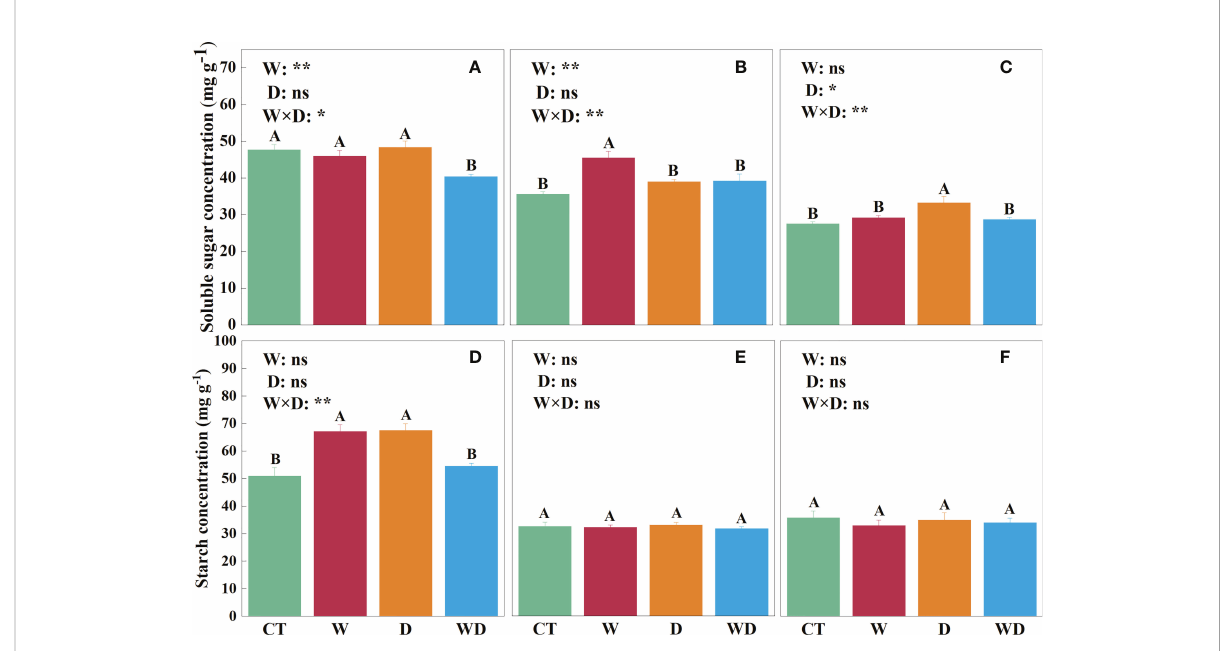
FIGURE 2 Effects of warming and drought on soluble sugar concentrations in the leaves (A) , roots (B) , and litter (C) , and starch concentrations in the leaves (D) , roots (E) , and litter (F) of C lanceolata . The bars with different letters were signi fi cantly different from each other ( p < 0.05). Treatments: control (CT), warming (W), drought (D), and warming plus drought (WD). Values were mean ± SE ( n = 5); treatment in the combination was expressed as W, warming effect; D, drought effect; and W×D, interactive effect of warming and drought; *, signi fi cant effect at p < 0.05; **, highly signi fi cant effect at p < 0.01; ns, no signi fi cant effect at p >